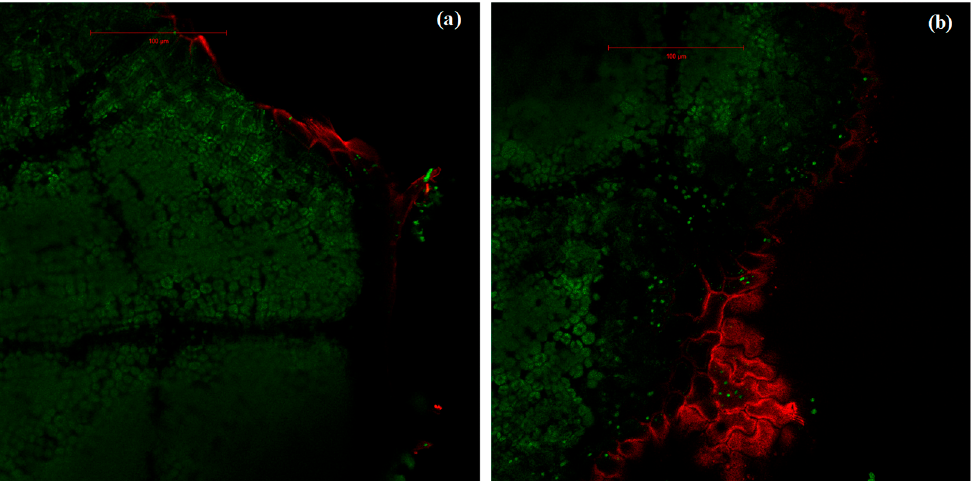
Figure 4. Intensities of rhodamine fluorescence (in red) and chlorophyll autofluorescence (green) in leaves of A. monspessulanum. ( a ) Leaf fumigated with isoprene where rhodamine fluorescence, marker of H 2 O 2 pressure, occurs only in the epidermis; ( b ) leaf not fumigated with isoprene where rhodamine occurs both superficially (cuticle and epidermis) and in deeper mesophyll tissue. Images correspond to section 6 from a moderate stress sapling leaf.